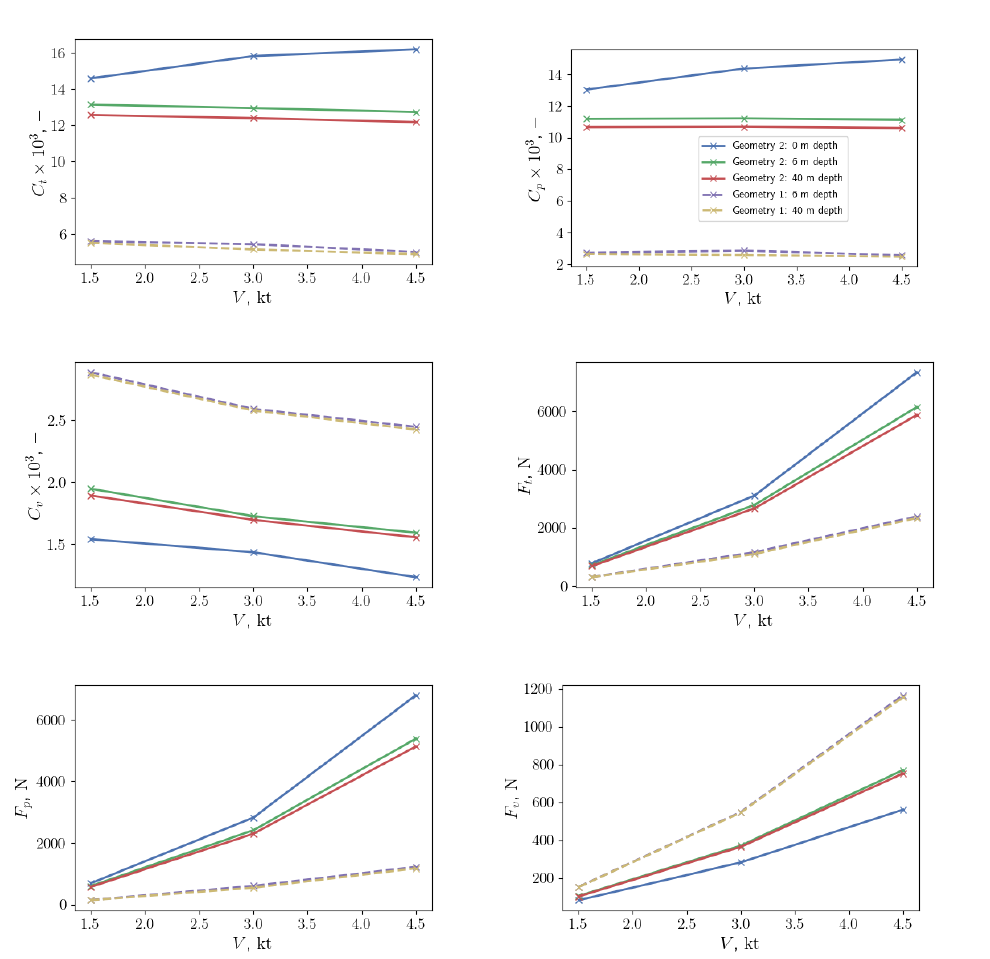
Figure 9. Total resistance of the smooth and simplified pressure hull, Geometry 1 and 2.